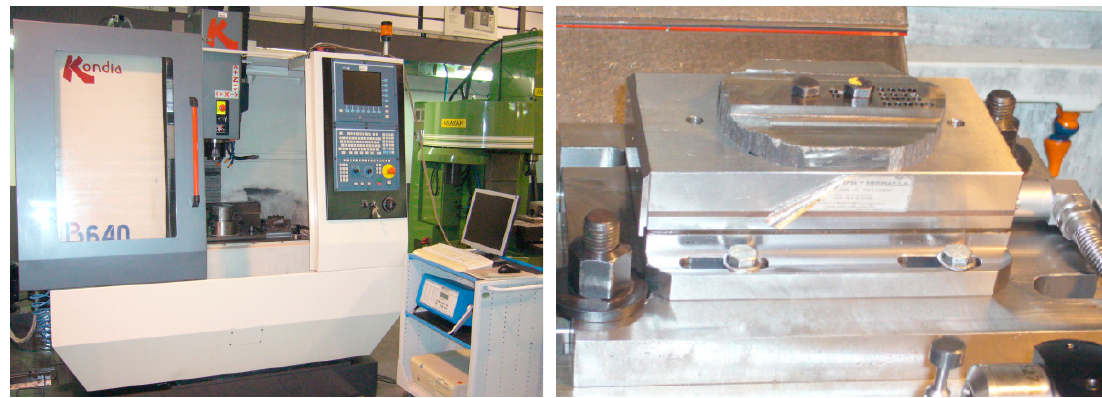
Figure 1. Kondia ® model B640 ( left ) and Kistler ® 9257B dynamometer ( right ).